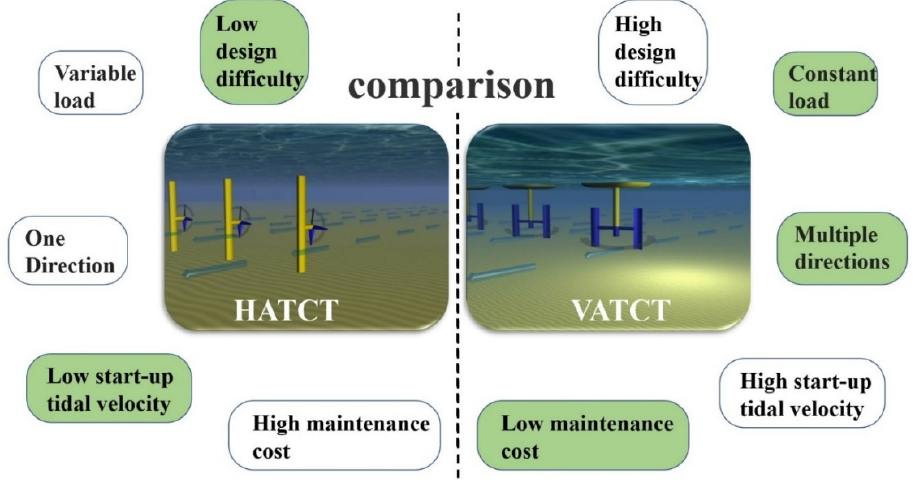
Figure 11. The comparison of HATCT and VATCT.